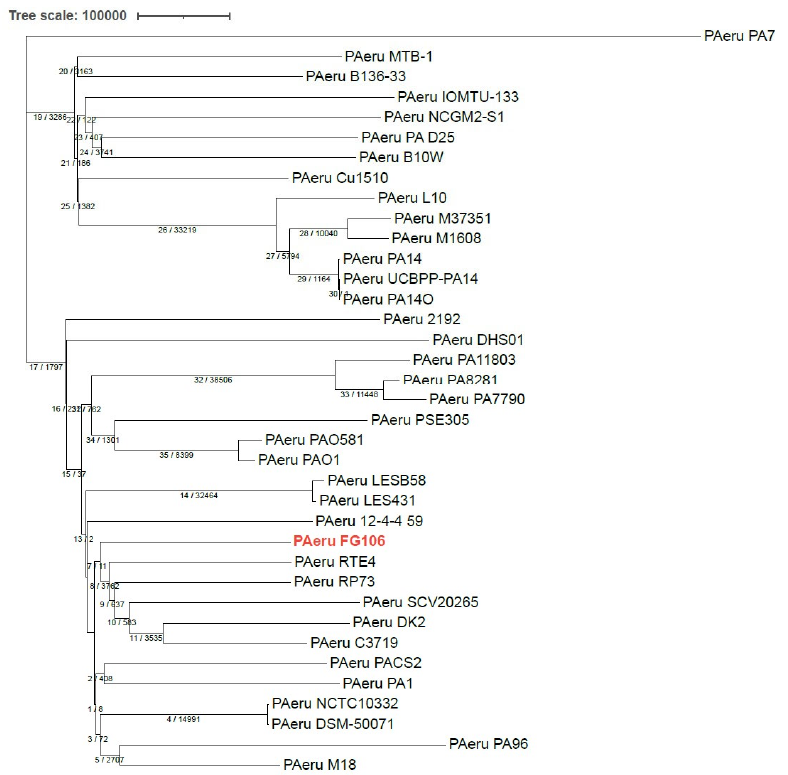
Figure 11. A neighbor joining (NJ) tree generated based on the number of core single nucleotide polymorphism (SNP) allele differences between sequences in the FG106 genome and 36 other P. aeruginosa strains. The tree was constructed using iTOL (https://itol.embl.de/ (accessed on 16 November 2021)) with Dendroscope. P. aeruginosa strain FG106 is written in red color. Numbers in the tree are node numbers (on the left) and numbers of SNP alleles (on the right).